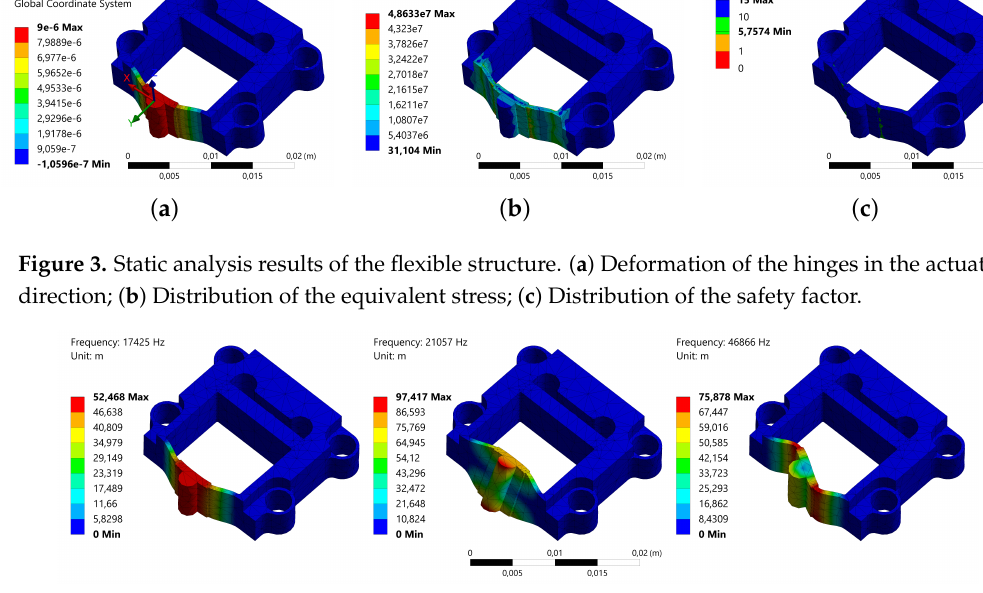
Figure 4. The first three dynamic modals of the flexible